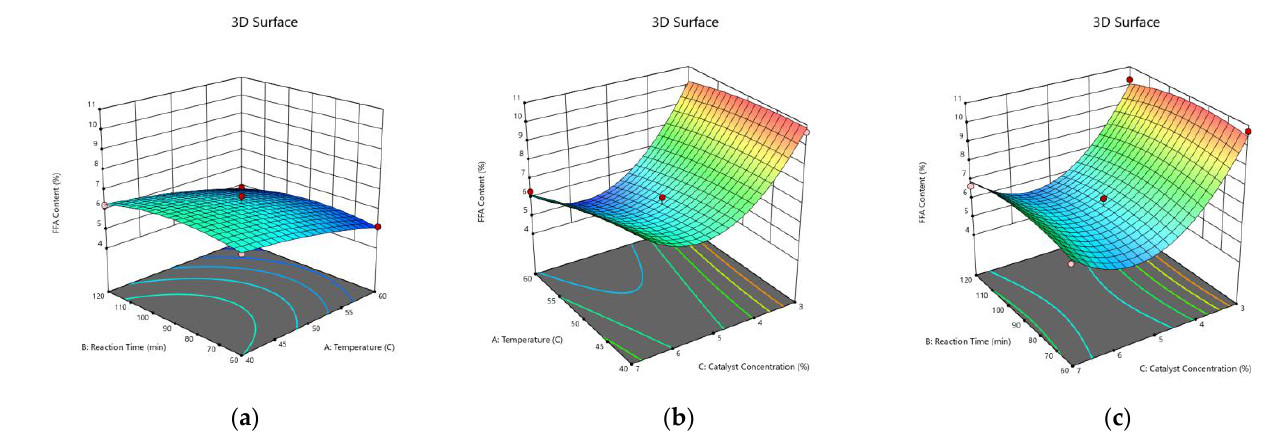
Figure 5. Three Dimensional (3D) Response Surface of the Effects of Process Variables on the FFA Content in after the Undergoing the Esterification Reaction. ( a ) Catalyst Concentration of 5%; ( b ) Reaction Time of 90 min; ( c ) Reaction Temperature of 50 ◦